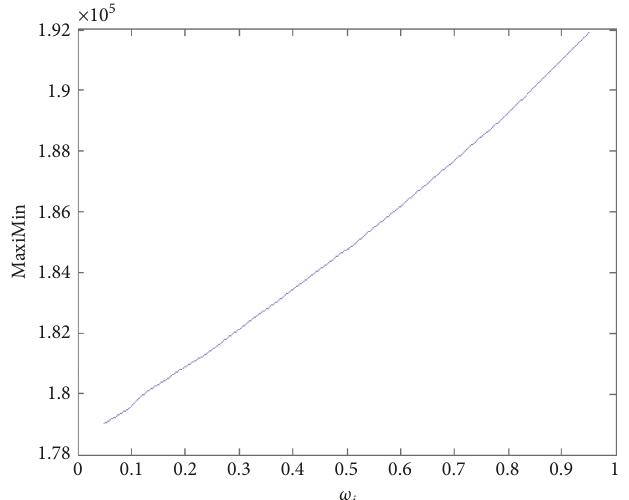
Figure 10: MaxiMin objective function with respect to ω